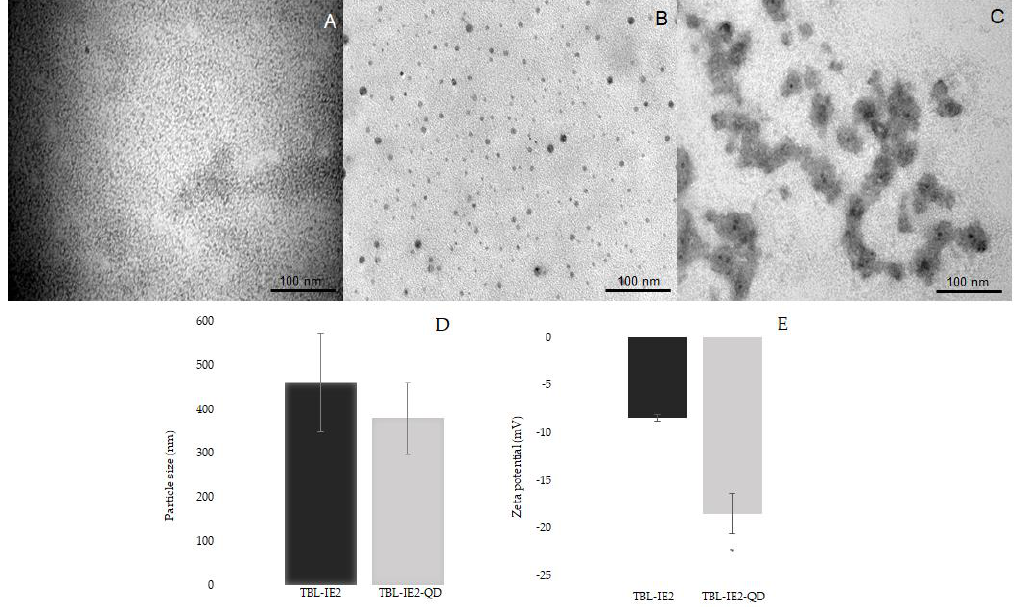
Figure 4. Physicochemical characterization of TBL-IE2 and TBL-IE2-QD complex. Transmission electron microscopy images for the TBL-IE2 and TBL-IE2-QD. The di ff erences between the unlabelled and labelled lectin are shown at 180,000 Kv magnification; ( A ) TBL-IE2, ( B ) TBL-IE2-QD complex coupled by microfluidics, and ( C ) TBL-IE2-QD complex coupled by covalent bonding. ( D ) Particle size analysis of TBL-IE2, compared to independent assays of the TBL-IE2-QD conjugate. ( E ) Zeta potential analysis of TBL-IE2, compared to independent assays of the TBL-IE2-QD conjugate. Asterisk shows statistically significant di ff erences ( p < 0.05).